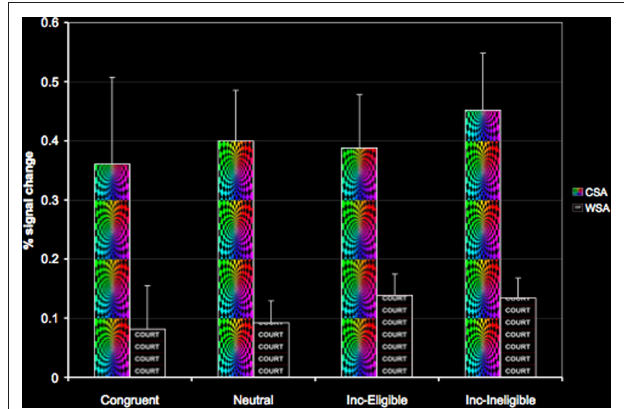
Figure 5 | Modulation of the CSA and the WSA in the four conditions of the Stroop